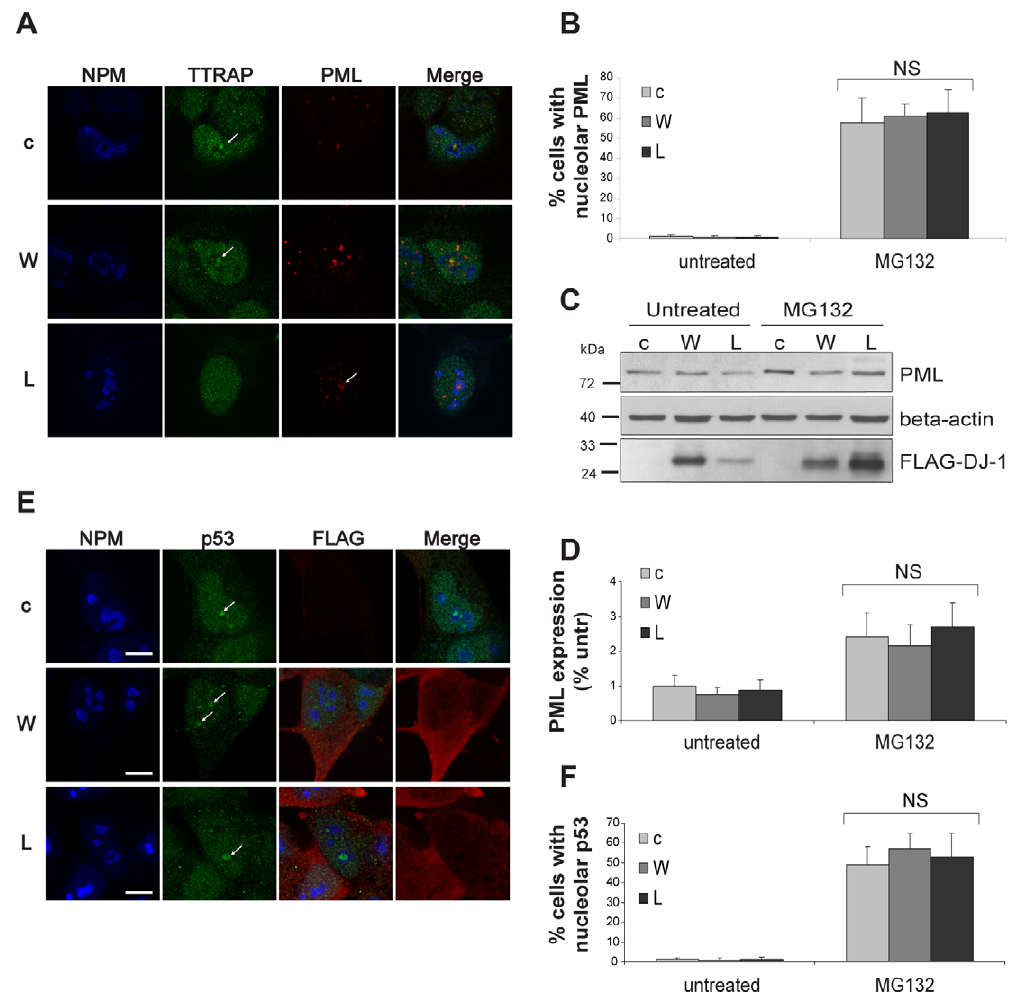
Figure 4. Mutant DJ-1 L166P does not inhibit nucleolar localization of PML and p53 upon proteotoxic stress. (A) Nucleolar localization of PML. SH-SY5Y cells stably expressing wt DJ-1 (W), L166P (L) or empty vector (c) were treated with 5 m M MG132 for 16 h. Endogenous TTRAP (green), PML (red) and NPM (blue) localization was analyzed by triple immunofluorescence. Images are representatives of two separate experiments performed on two independent clones for each cell line. (B) Quantification of PML nucleolar localization. Cells were treated as in A. 200 cells from two independent experiments were counted and scored for PML in the nucleolus (*, p , 0.05). (C) Mutant DJ-1 L166P does not affect levels of endogenous PML. SH-SY5Y cells stably expressing wt DJ-1 (W), L166P (L) or empty vector (c) were treated with 5 m M MG132 for 16 h or left untreated, as indicated. The expression of endogenous PML and overexpressed FLAG-DJ-1 were measured with anti-PML and anti-FLAG antibodies, respectively. Beta-actin was detected as loading control. (D) Quantification of PML levels. Densitometric analysis of protein bands was performed on two independent experiments. Relative expression of endogenous PML was normalized to beta-actin. Data are expressed as the percentage of untreated condition in empty cells (c). (E) Nucleolar localization of p53. Cells were exactly as in A. Localization of endogenous p53 (green), NPM (blue) and FLAG-DJ-1 (red) were analyzed by triple immunofluorescence. Bars, 10 m m. (F) Quantification of p53 nucleolar localization. Analysis was performed as in B (NS, non